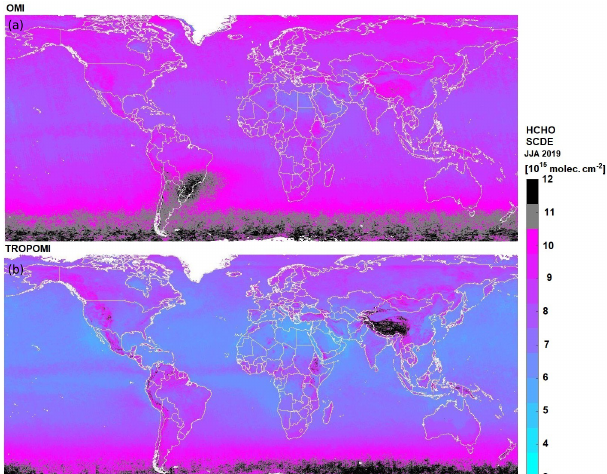
Figure 3. Average HCHO slant column density fitting error (SCDE) retrieved from OMI (a) and TROPOMI (b) in JJA 2019, on a spatial grid of 0.05 ◦ in latitude and